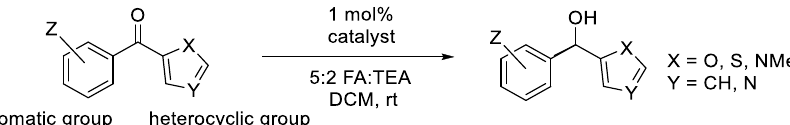
Figure 16. ATH of hetereocyclic/aromatic ketones — reported examples. Ketones where Ar = Ph, o -(MeO)C 6 H 4 (oOMe), o -(Me)C 6 H 4 (oMe), o -(Br)C 6 H 4 (oBr), o -(Br)C 6 H 4 (oCl) and α -naphthyl (Np) versus Het = 2-furyl (Fu), 2-thienyl (Thio), 2- N -methylimidazole (Im) and 2- N -methylpyrrole (PyMe) were studied. The results indicated that the electron-rich heterocyclic rings are more competitive and adjacent to the η 6 -arene ring in transition state (Figure 17).